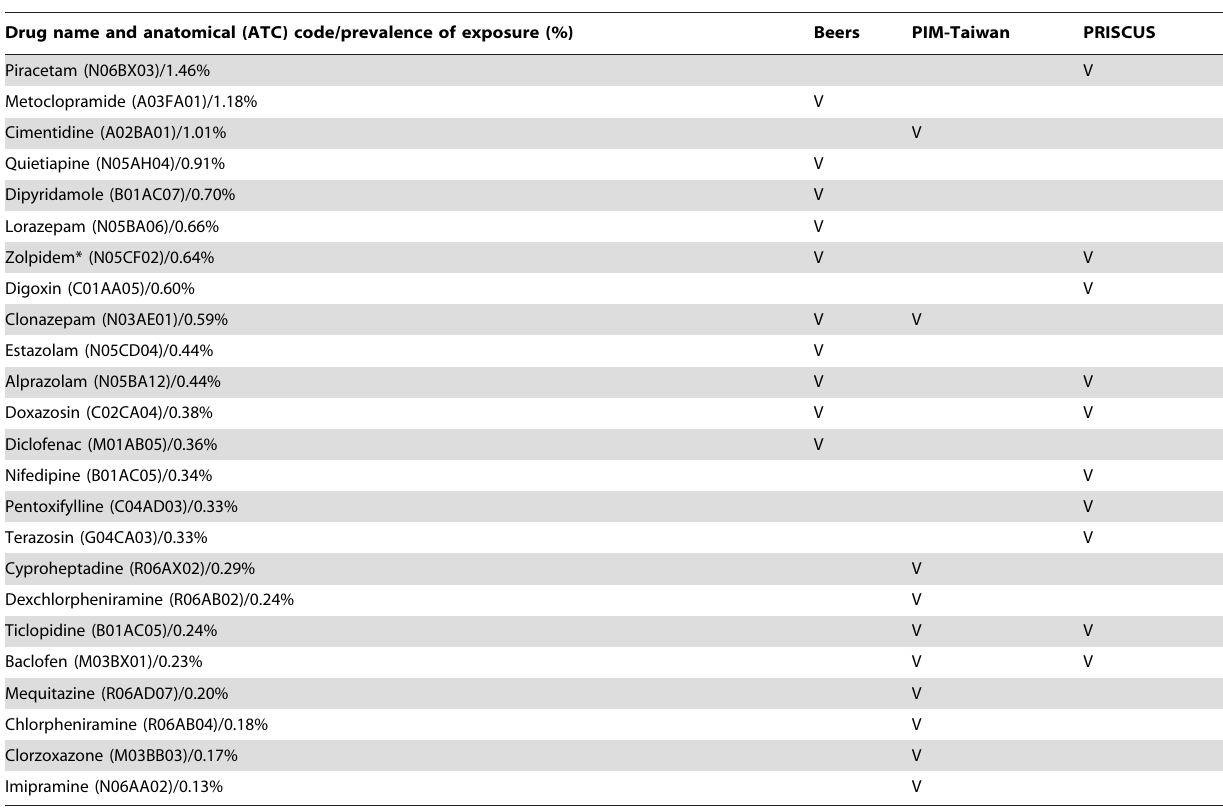
Table 7. The leading ten potentially inappropriate medications (PIMs) identified in 2,428,222 prescribed medications.